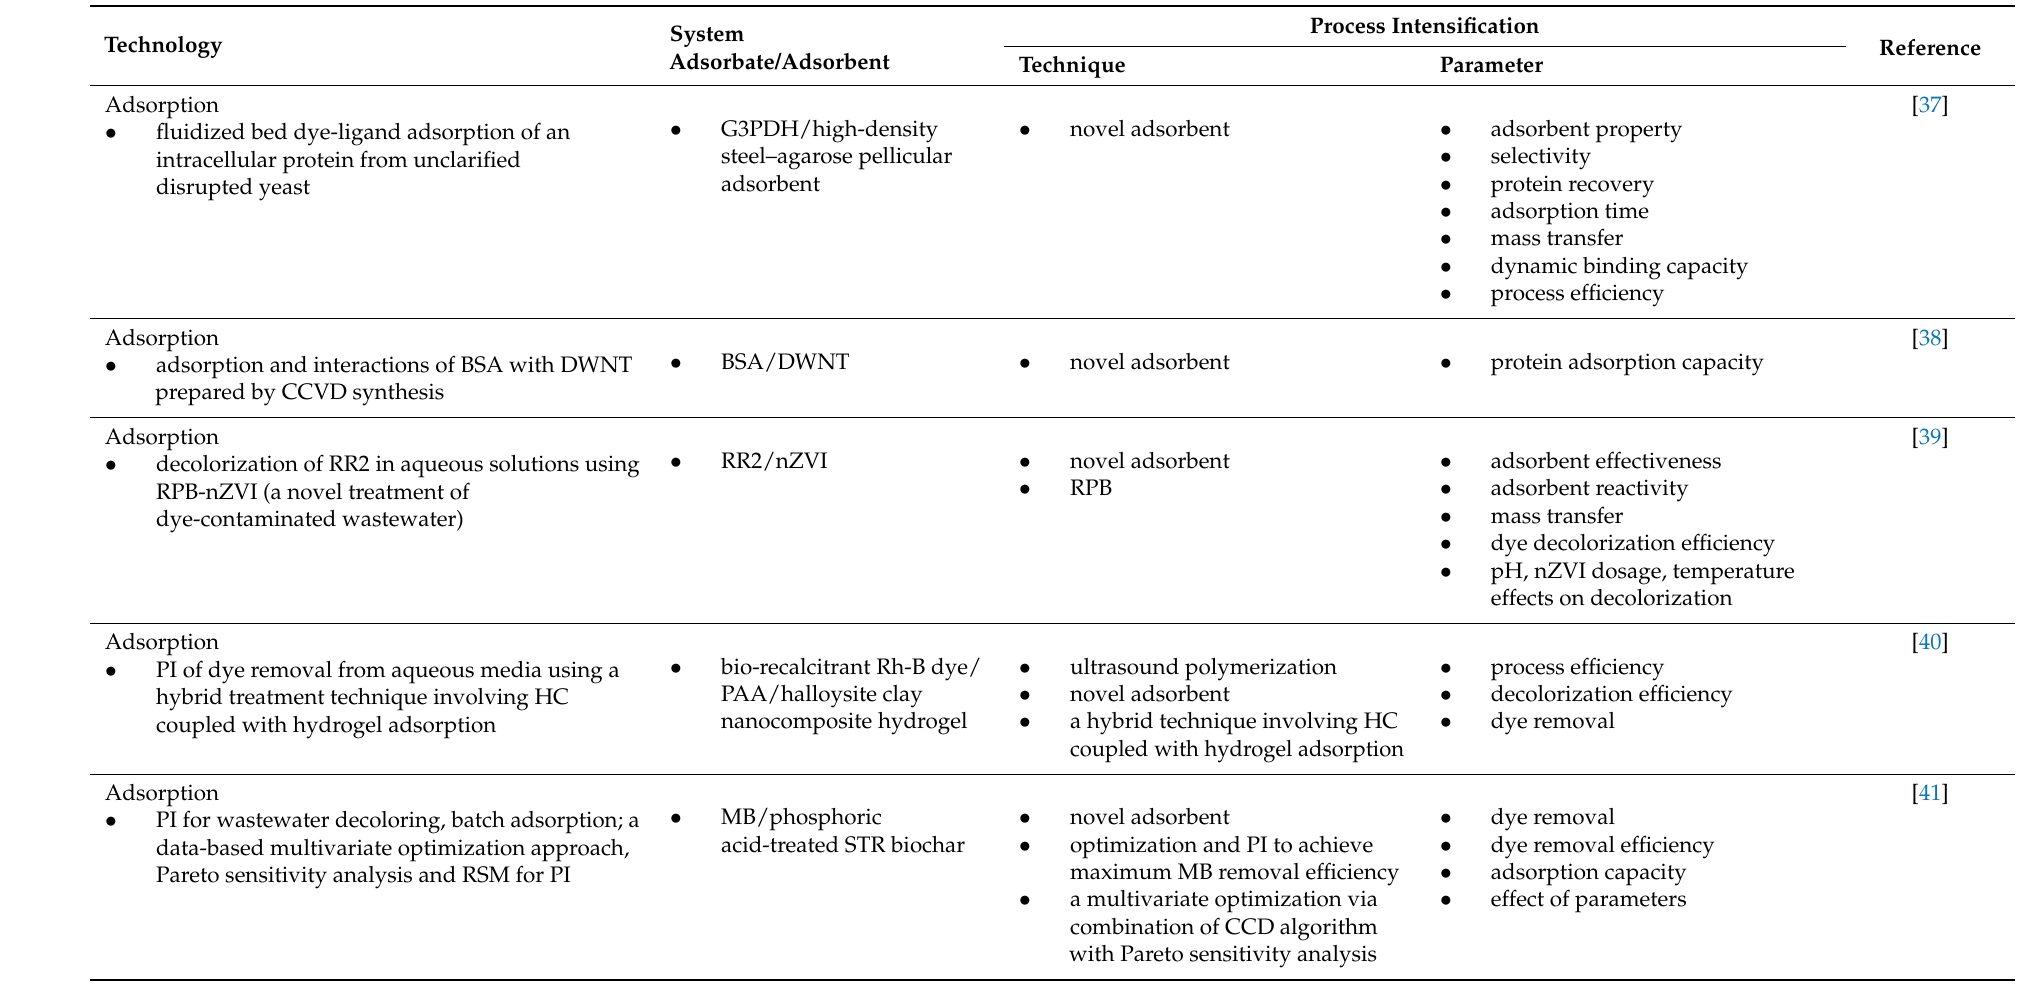
Table 1. Selected process intensification techniques in the literature applied to the decolorization of dyes; removal of aromatic hydrocarbons from wastewaters; and recovery of proteins, heavy metals and rare earth elements from aqueous